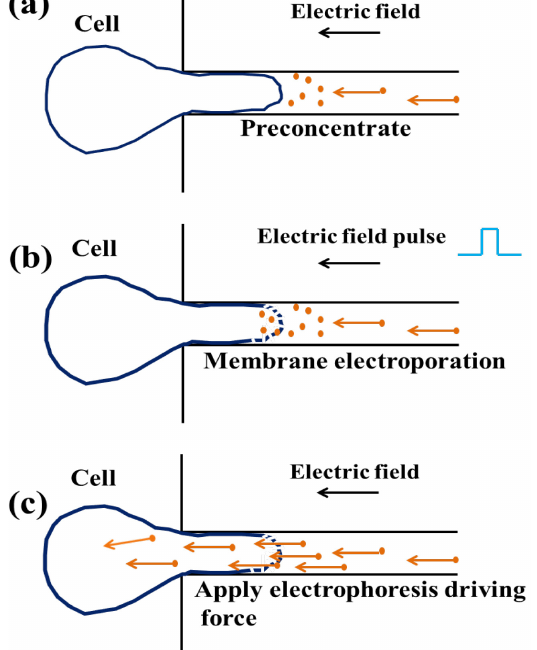
Figure 7. The schematic steps for electrophoresis driven cell loading protocol ( a ) preconcentrate; ( b ) membrane electroporation; ( c ) apply electrophoretic driving force. Figure has been redrawn with reference